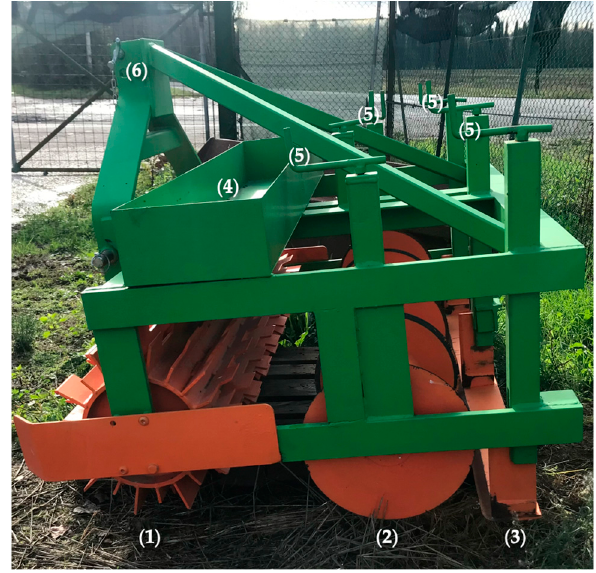
Figure 2. Lateral view of the prototype: ( 1 ) roller crimper; ( 2 ) cylindrical drum with five cutting discs; ( 3 ) undercutting blade; ( 4 ) hopper; ( 5 ) telescopic servo rudders; ( 6 ) three-point hitch.